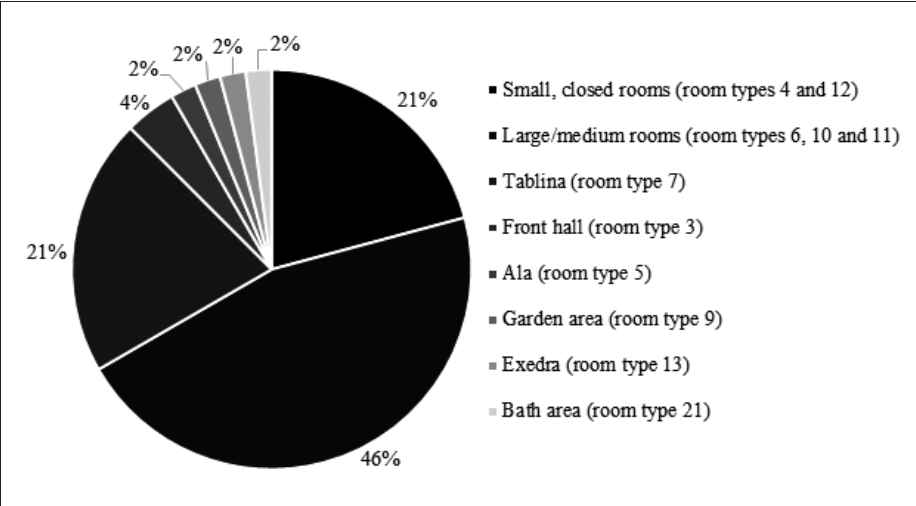
Figure 1: The location of love scenes featuring Venus in domestic contexts in